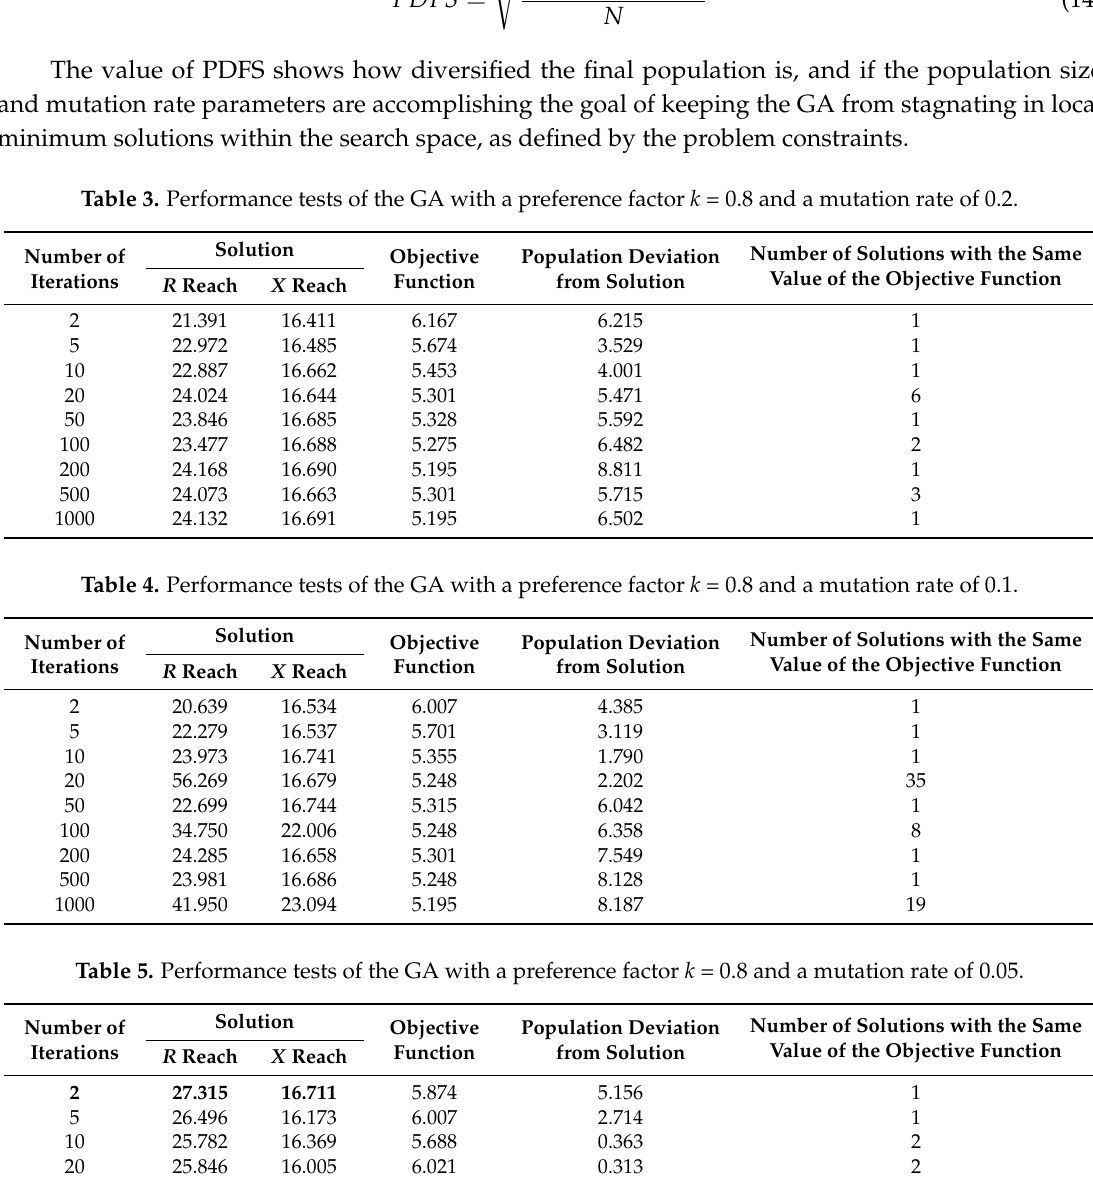
Number of Solutions with the Same Value of the Objective Function R Reach X